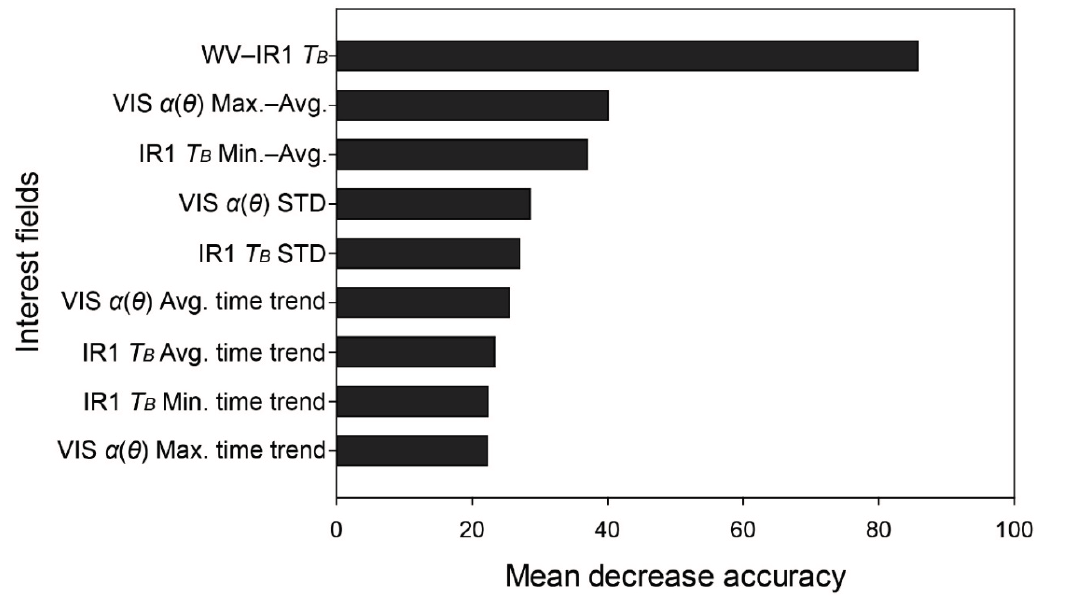
Figure 4. Mean decrease accuracy calculated using out-of-bag data when a variable was permuted in RF. The greater the decrease in accuracy, the more contributing the variable